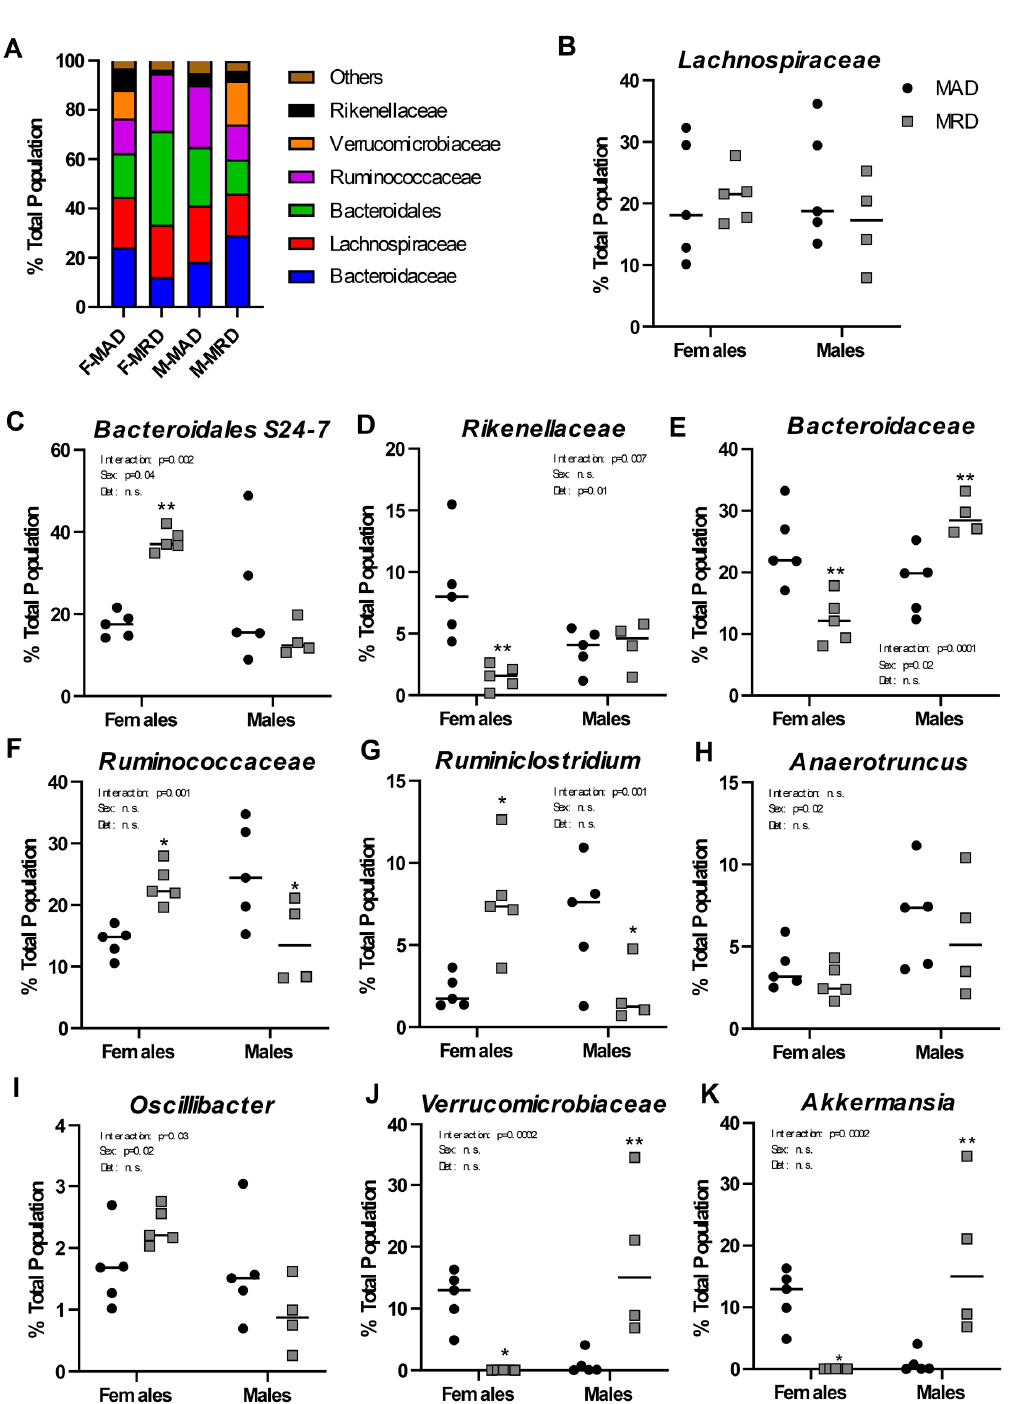
Figure 3. Changes in microbial populations. Panel ( A ). Overview of the bacterial families present in samples from each group as a function of % of the total population. Panels ( B – K ). Abundance of bacterial families ( B , D – F , J ) or genera ( C , G – I , K ) in male and females by diet group. Mean ± SEM, MAD: methionine adequate diet, MRD: methionine-restricted diet. Data were analyzed using a two-way ANOVA followed by Sidak’s multiple comparisons test to compare the two diets within each sex. * indicates p ≤ 0.05, ** indicates p ≤ 0.01, and *** indicates p ≤ 0.001. n.s. = Non